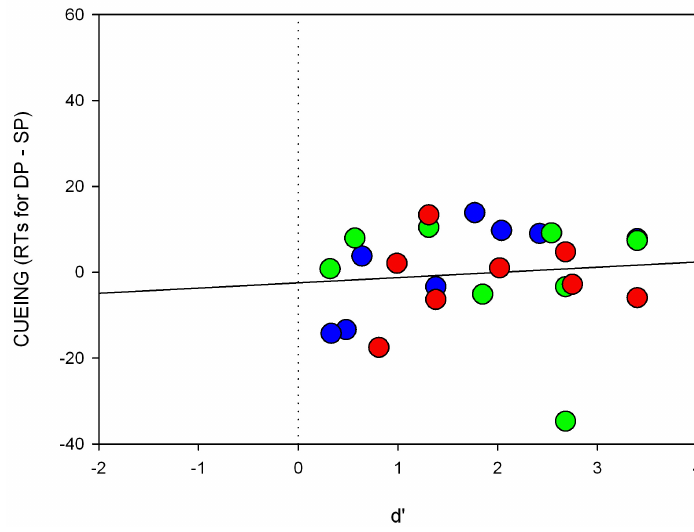
Figure A4. Individual scatter plots of the short SOA for Experiment 4. Shown are RT differences (cueing effects, y -axis) and the respective d’ -value ( x -axis) for each participant separately. The colors of the circles correspond to the respective searched-for target